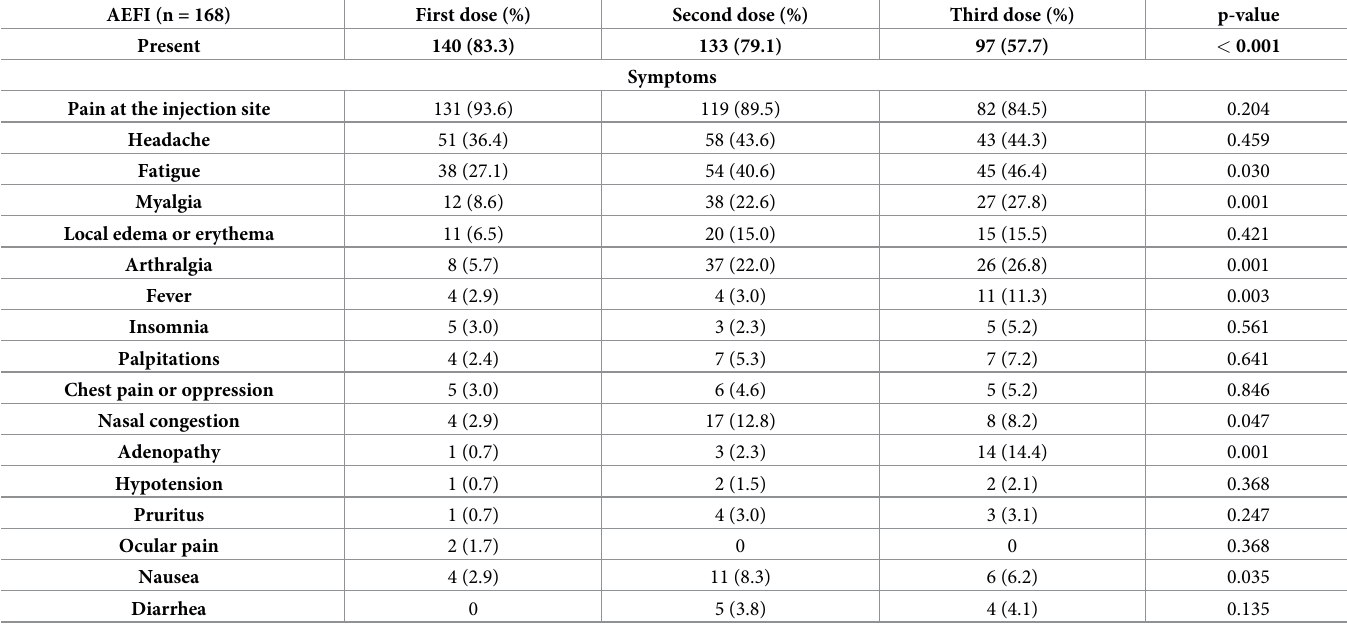
Table 5. Adverse events following immunization after each administered BNT162b2